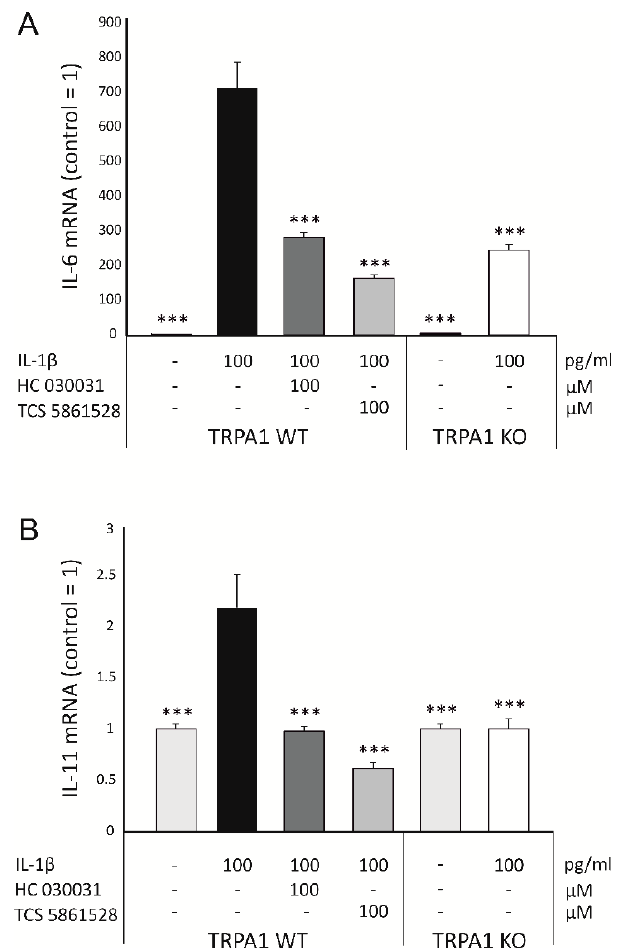
Figure 1. IL-1 β -induced IL-6 ( A ) and IL-11 ( B ) expression is attenuated by genetic deletion and pharmacological inhibition of TRPA1 in murine chondrocytes. Chondrocytes were obtained from TRPA1 deficient (knockout, KO) mice and corresponding wild-type (WT) mice. The chondrocytes were cultured with IL-1 β (100 pg/mL) alone, or together with the selective TRPA1 antagonist HC- 030031 (100 μ M) or TCS 5861528 (100 μ M) for 24 h and thereafter total RNA was extracted. IL-6 and IL-11 mRNA levels were measured with qRT-PCR and normalized against glyceraldehyde 3-phosphate dehydrogenase (GAPDH) mRNA levels. The results are expressed as fold change in comparison to the control samples of each genotype. WT n = 13 (TCS treatment n = 10), KO n = 15. Results are expressed as mean + SEM. One-way ANOVA followed by Bonferroni post-test was performed; *** p < 0.001. (Adapted from the doctoral dissertation of the first author